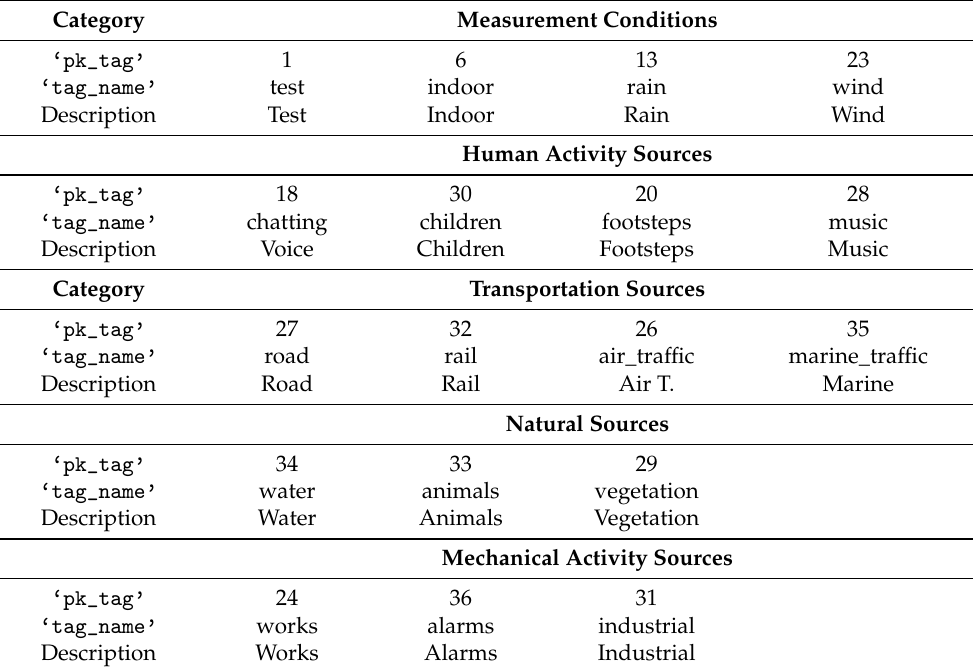
Table 19. Tags description: ‘pk_tag’ and ‘tag_name’ are the primary key and the name of the tags. The ‘Description’ correspond to the name of the tag in the corresponding NoiseCapture screen.